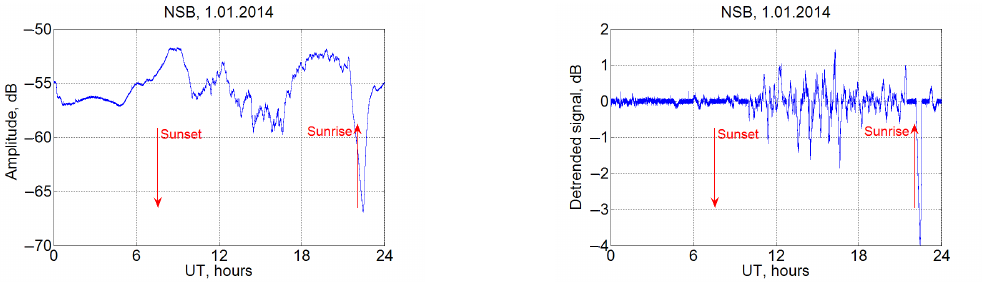
Figure 6. Amplitude variations ( left ) and detrended signal ( right ) by NSB station measurements, 1 January 2014